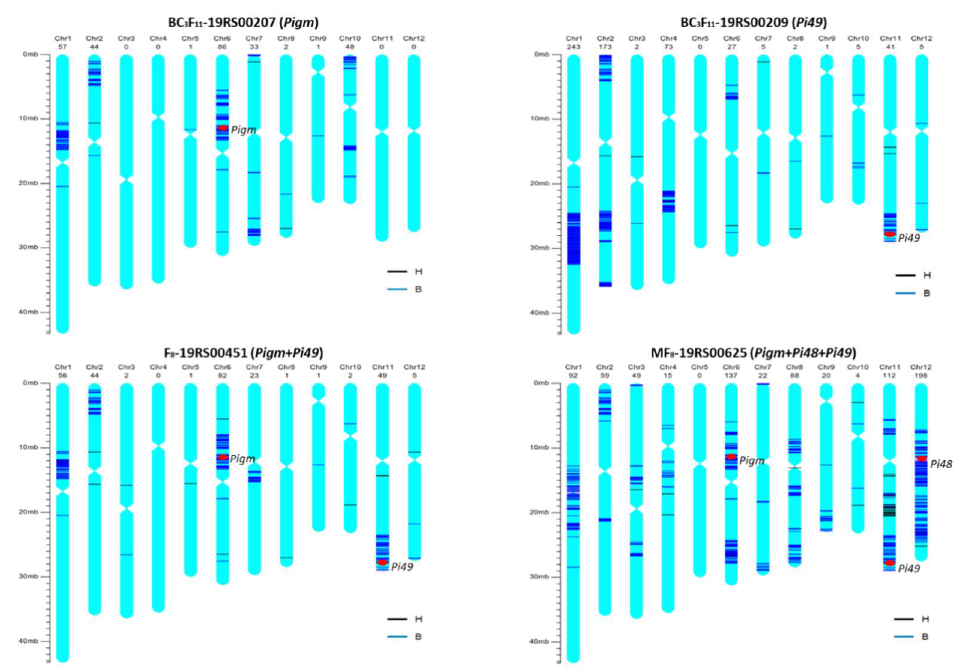
Figure 4. Genetic background of improved lines using the 10K array. The blue color represents homozygous genotype different from C5S, and the black color represents heterozygous genotype. The red dots indicate the positions of the target blast resistance genes.